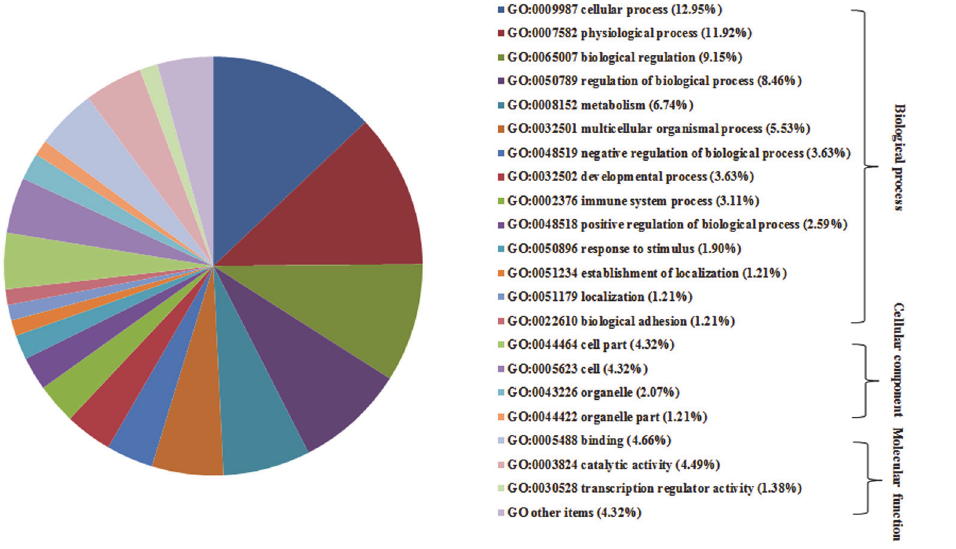
Fig 3. GO categories of the hypomethylation genes. GO categories for the hypomethylation genes. The genes were classified into biological processes, cellular component, and molecular function.